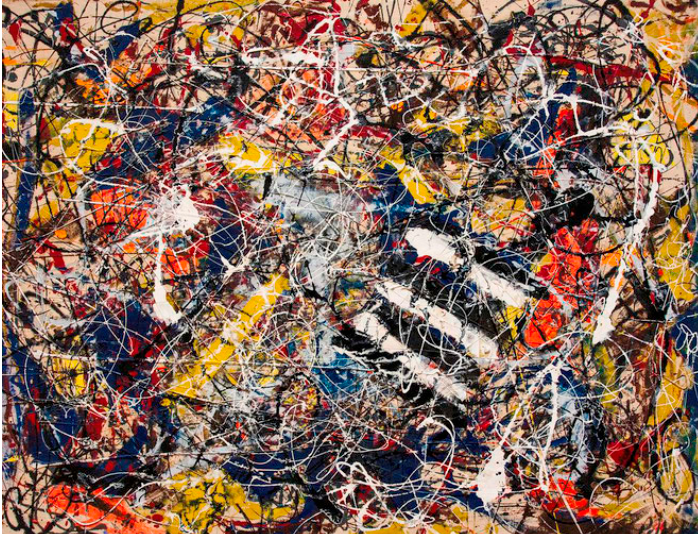
Figure 7. One of the Jackson Pollock’s drawings (in public domain).